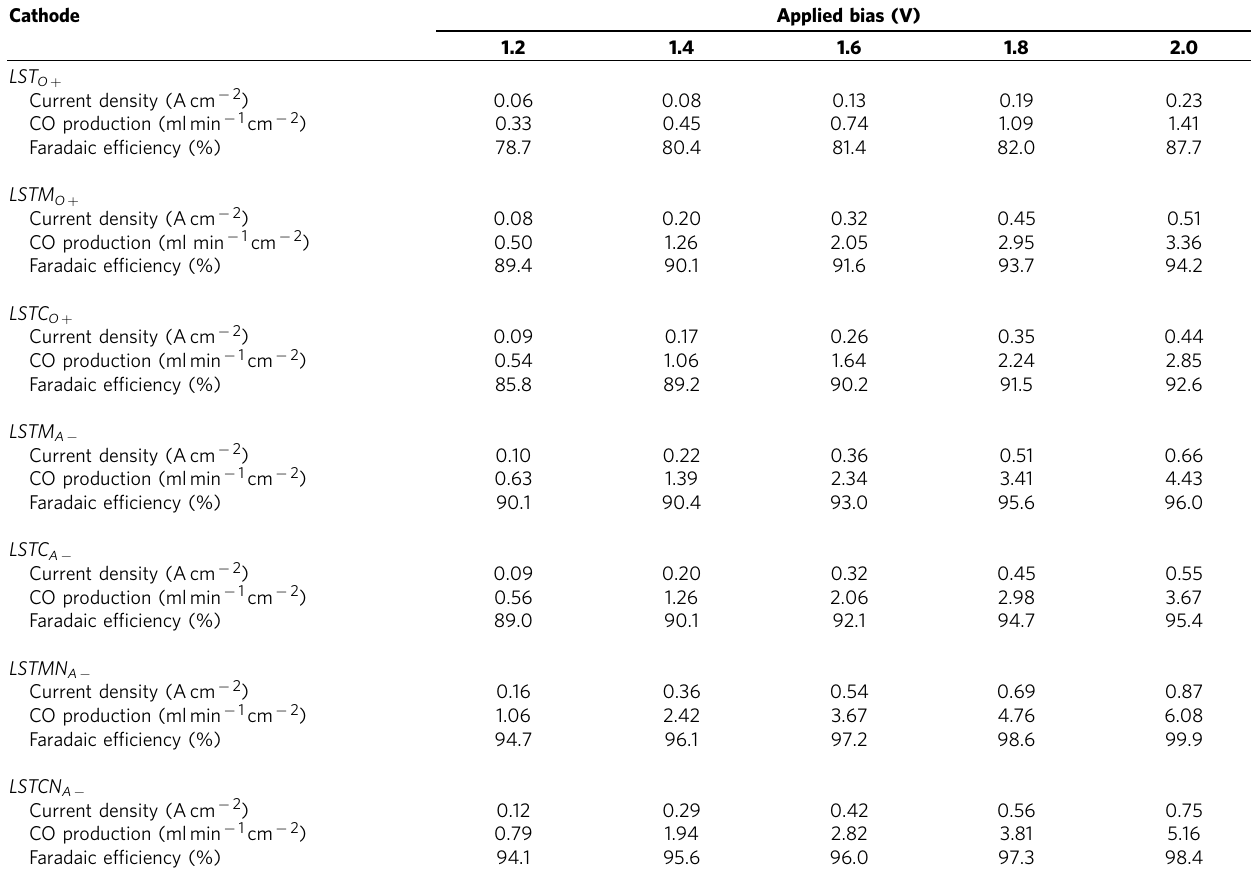
Table 1 | Performance with different cathodes.